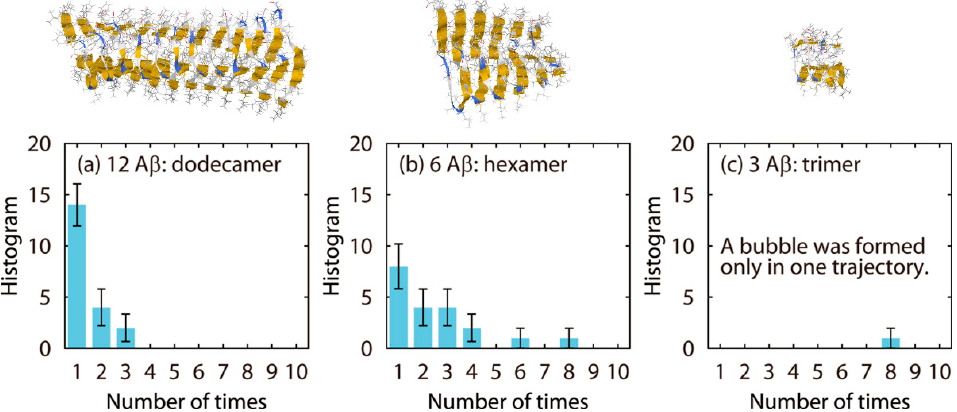
Figure 14. Histograms that show how many times the pressure had been negative before the amy- loid fibril was destroyed for the ( a ) dodecamer, ( b ) hexamer, and ( c ) trimer systems. Reprinted with permission from Ref. [80]. Copyright 2014 American Chemical Society.